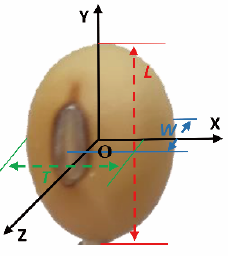
Figure 1. Triaxial sizes of one single soybean particle under the space rectangular coordinate system.